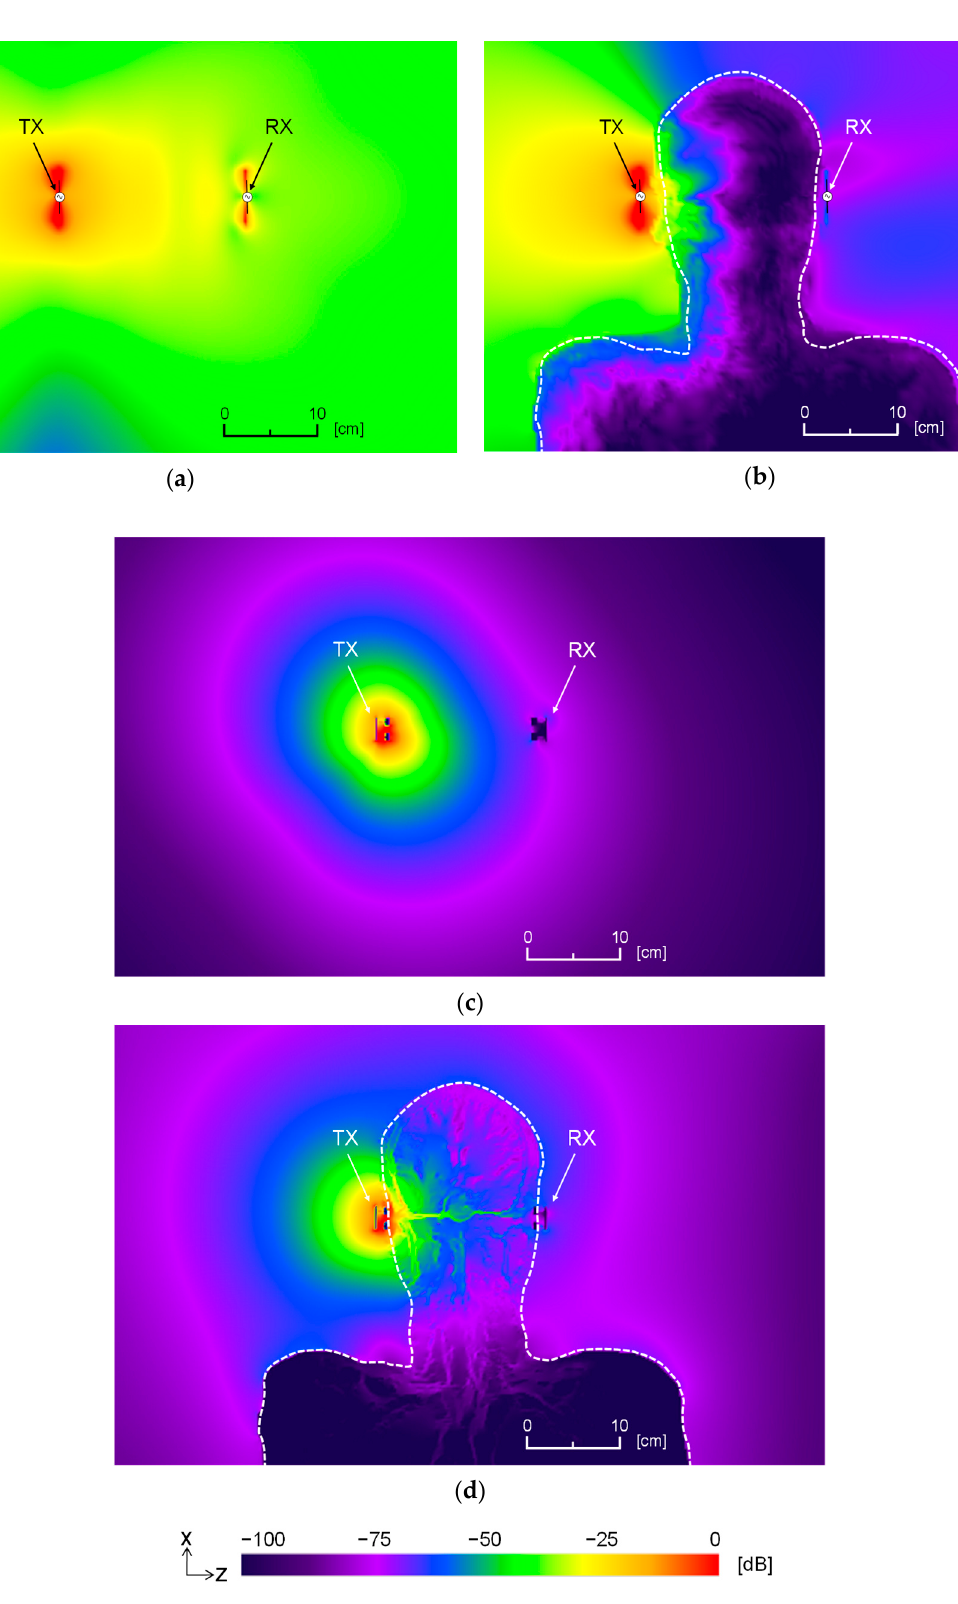
Figure 5. Electric field distributions under the four simulation conditions: ( a ) 2.45 GHz wireless communication (WC) without the body; ( b ) 2.45 GHz WC with the body; ( c ) HBC without the body; ( d ) HBC with the body Table 1. Transmission characteristic S 21 under the four simulation conditions.